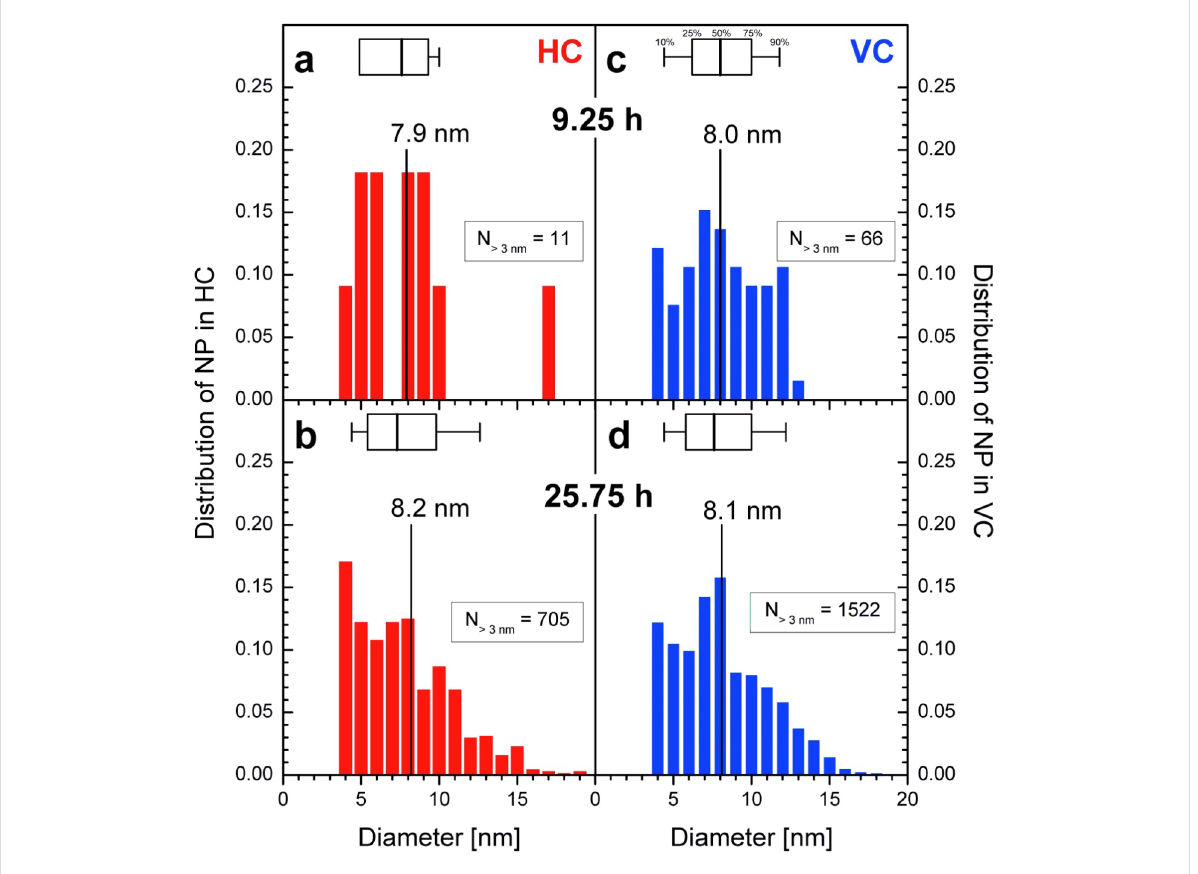
Figure 9: Distribution of the diameter of nanoparticles formed in the heterocysts (HC) and vegetative cells (VC) of Anabaena cylindrica as obtained from TEM images with 50k. Distributions of nanoparticles larger than the reliable detection limit of 3 nm are shown in the left column for HC (a, b) and in the right one for VC (c, d) after 9.25 hours (a, c) and 25.75 hours (b, d) of incubation with an overall concentration of 0.8 mM Au 3+ . In each panel the mean size (vertical labeled line) is shown as well as a box plot (25% | 50% | 75%) with whiskers for 10% and